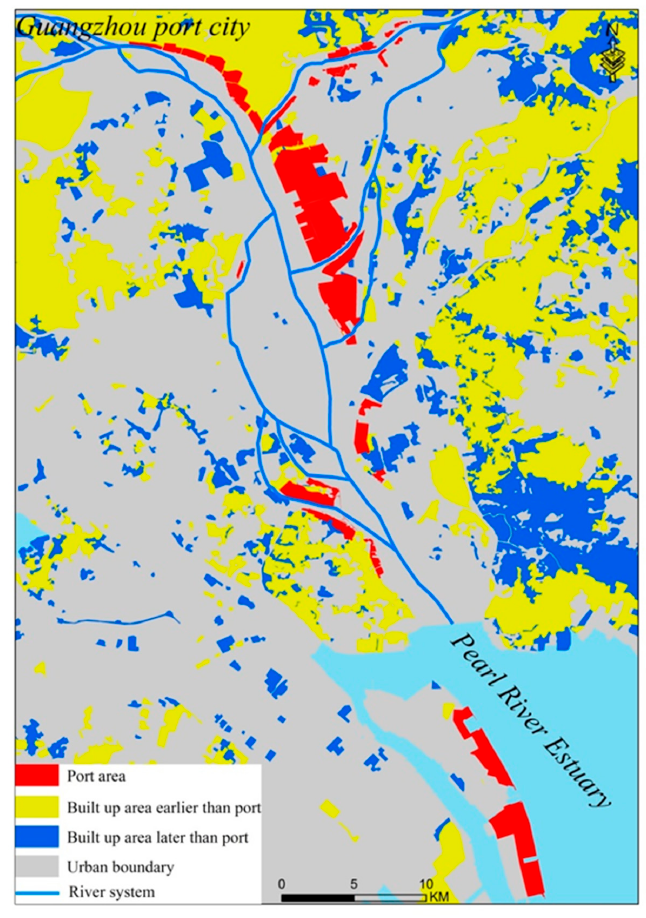
Figure 4. Spatial change of estuary port–city interface (source: drawn by author).